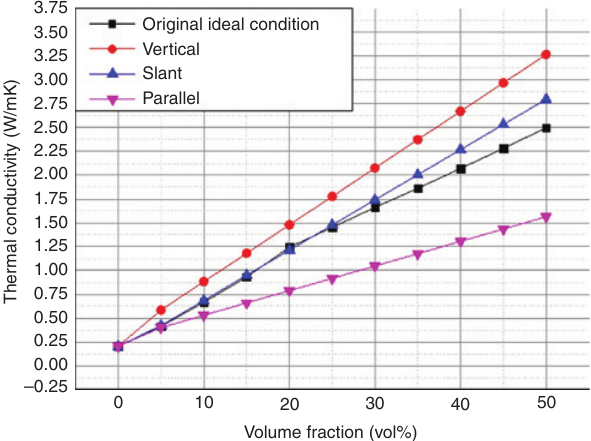
Figure 6: Investigation of the influence from the dependence on particle